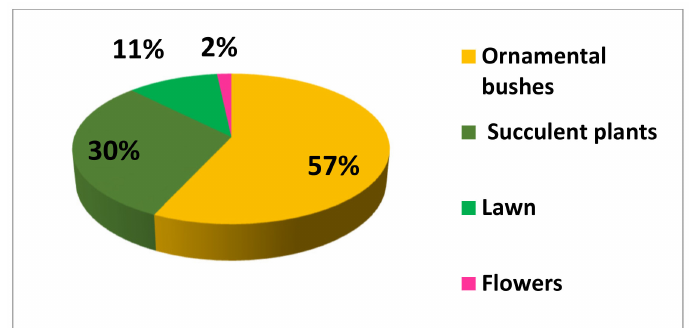
Figure 5. Surface occupied by the di ff erent types of vegetation in the gardened areas of the schools (%). Source: survey results. Own